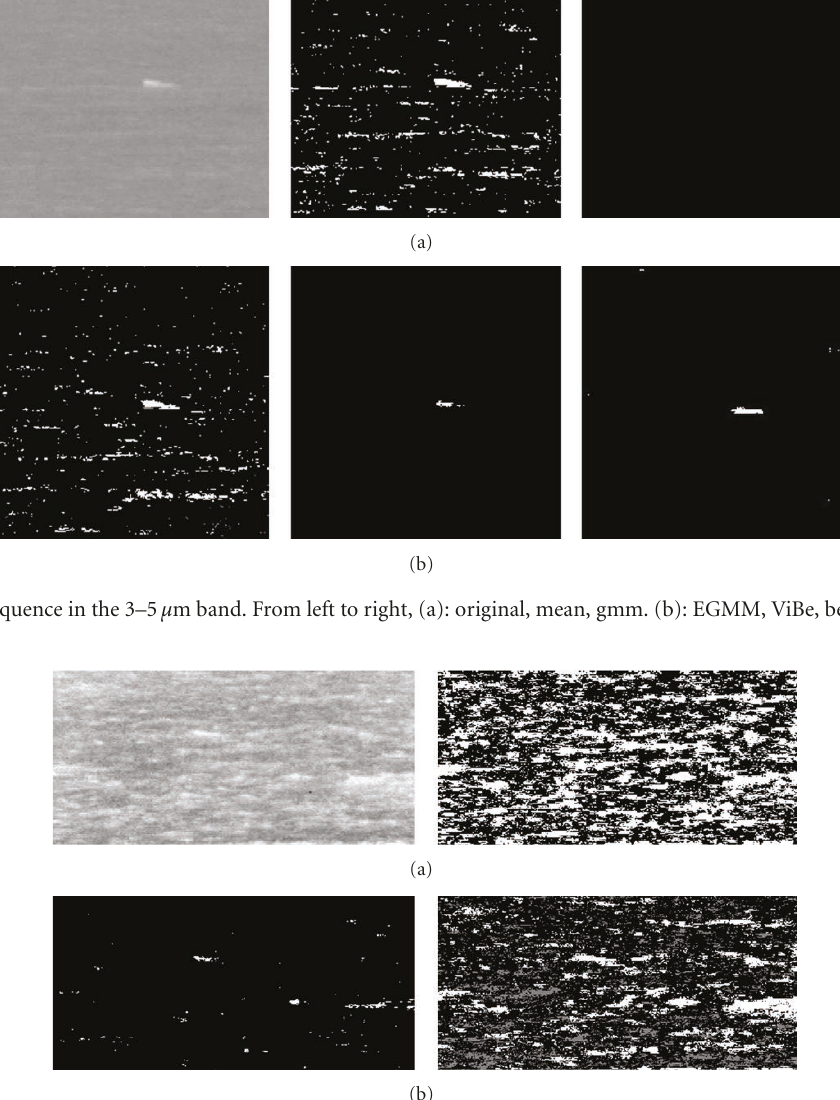
= 0 if a < 0. Similarly to (1), a binary where (cid:8) a (cid:9) 0 mask M t can be obtained by thresholding this distance function, e ff ectively subtracting the background behaviour and detecting foreground